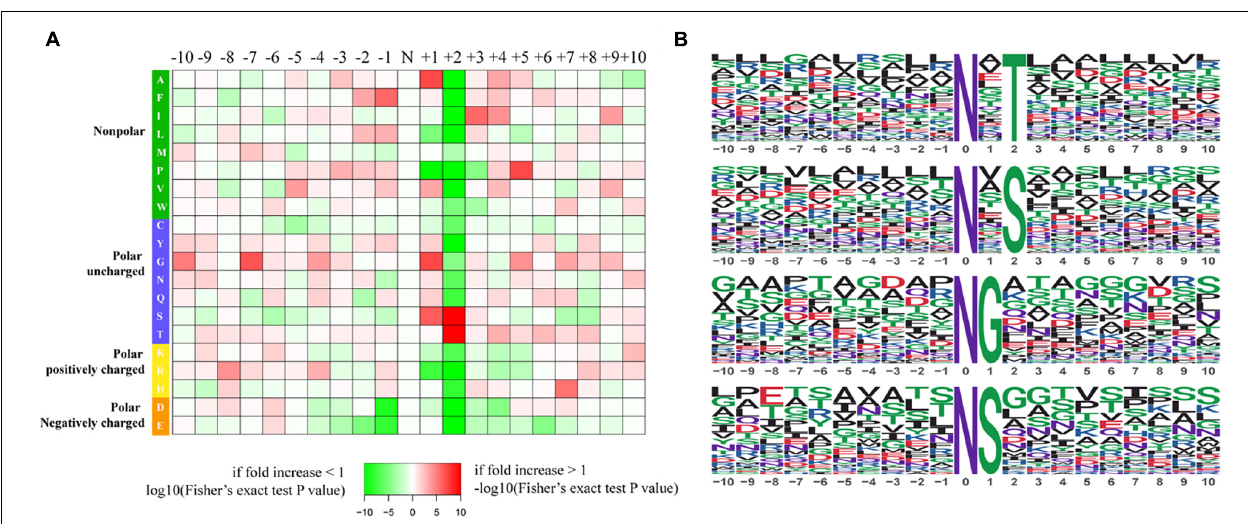
FIGURE 2 | Characteristics of the N-glycosylation sites. (A) The motif enrichment heatmap of upstream and downstream amino acids of all identified modification sites. Red indicates that this amino acid is significantly enriched near the modification site, and green indicates that this amino acid is significantly reduced near the modification site. (B) The main motifs modified by